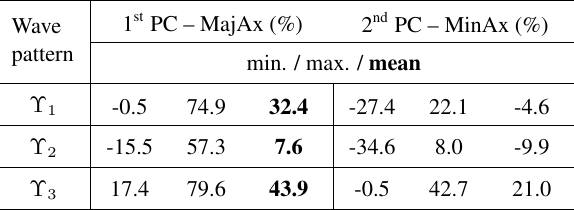
Table 3: Change in laser footprint size specified as difference be- tween the first principal component (1 st PC) and the ellipse major axis (MajAx) resp. the second principal component (2 nd PC) and the ellipse minor axis (MinAx) (in percent of water